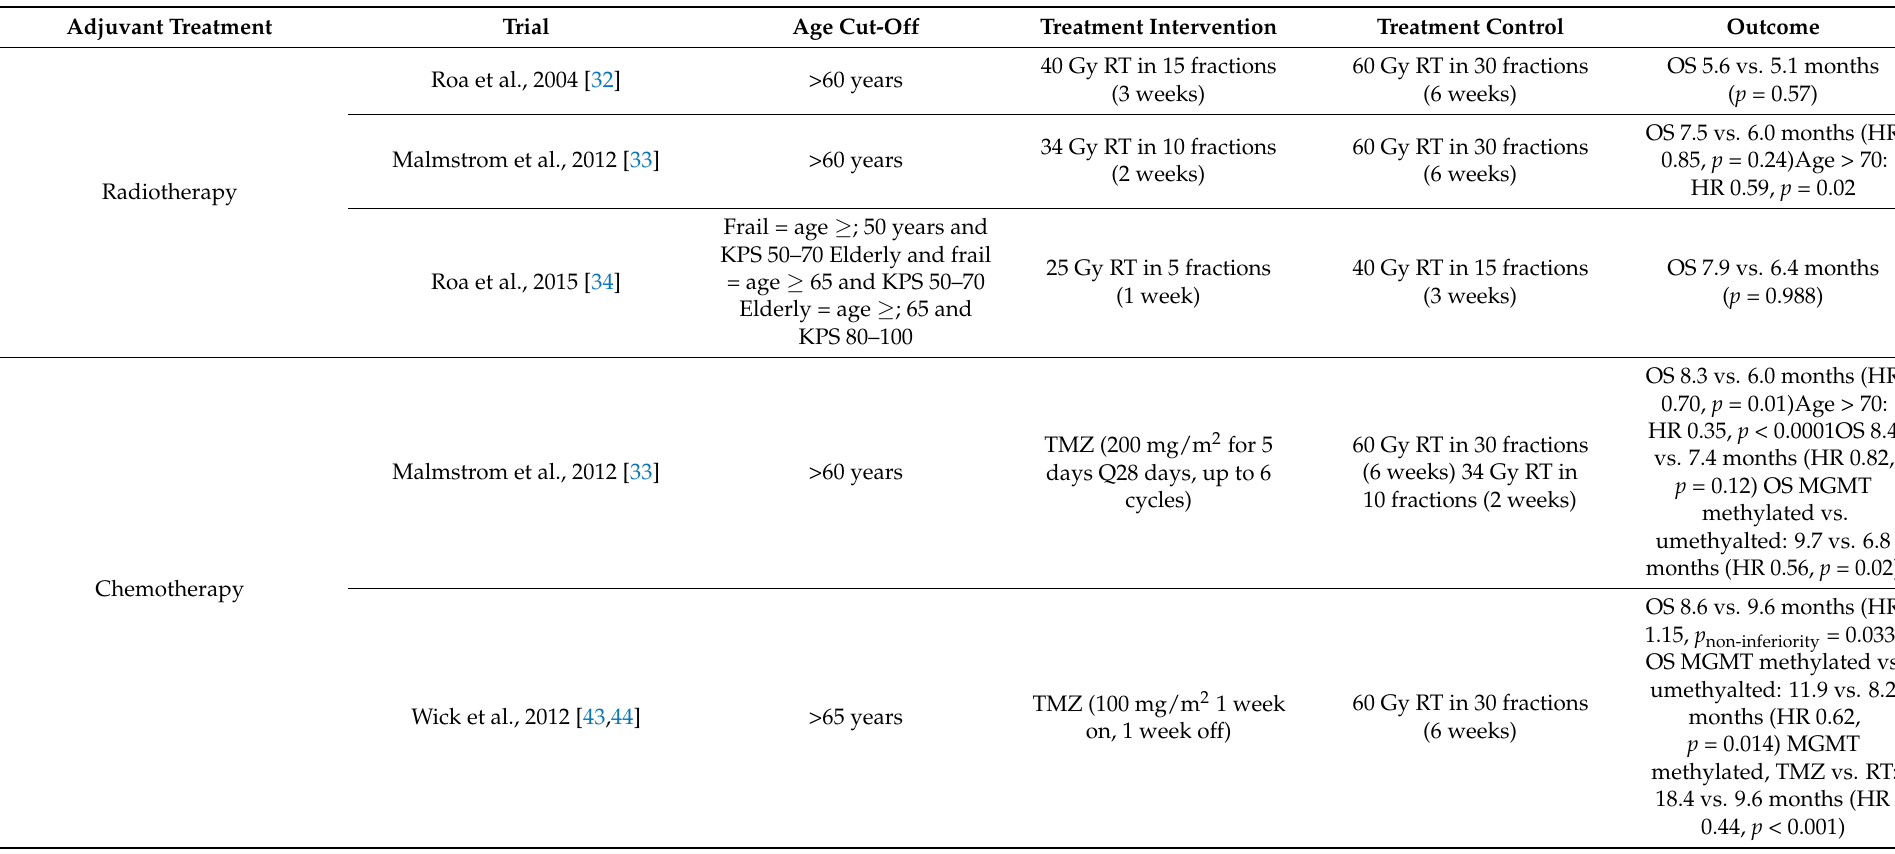
Table 1. Pivotal trials providing evidence for adjuvant therapy in older adults with